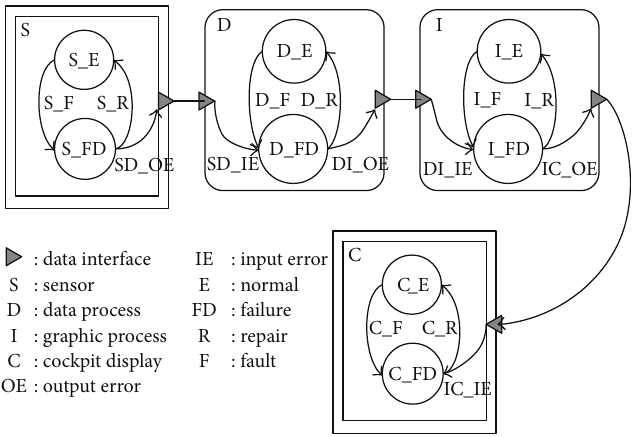
Figure 15: AADL reliability model of basic cockpit display